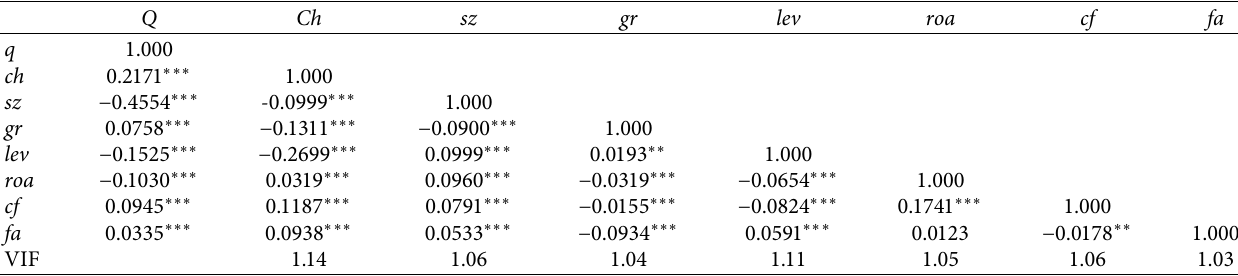
Table 2: Correlation matrix and variance inflation factor (VIF) of variables.